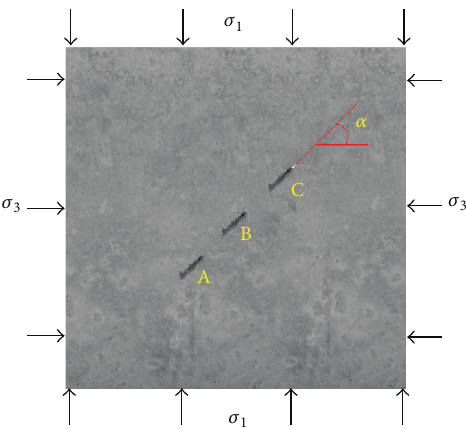
Figure 1: A concrete specimen with three collinear cracks.